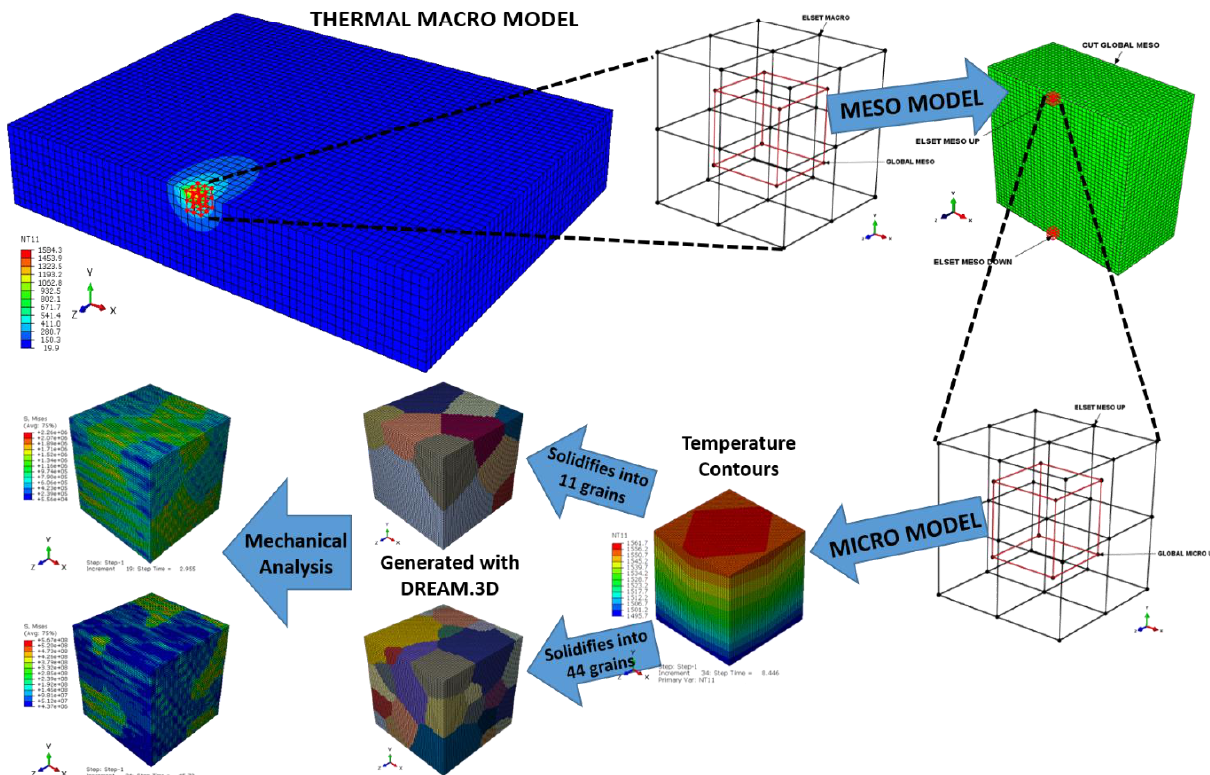
Figure 3. The multiscale mesh strategy applied in an initial coarse thermal macro global model. The zoomed-in volume illustrates the finite element submodeling technique. The (representative volume elements) RVE-finite element polycrystalline meshes were constructed by using the coupling DREAM.3D-ABAQUS. The coarse thermal macro mesh is composed of 48,600 DC3D8 2 mm elements. The RVE micro finite element mesh is composed of 125,000 C3D8 1 µm elements for the mechanical analysis, and 125,000 DC3D8 1 µm elements for the thermal analysis.